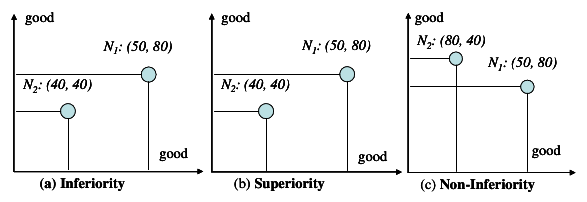
Fig. 1. Three relationships among chromosomes in MOGA